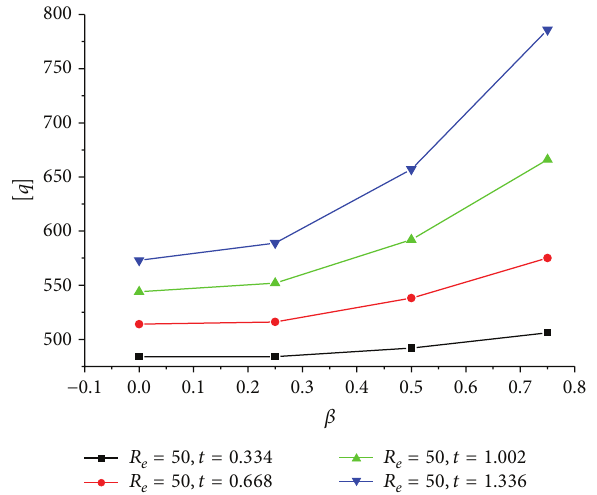
Figure 12: [𝑞] - 𝛽 relation of the CFRP sheet confined GFRP pipe when 𝑡 are constants and 𝑅 𝑒 is 50